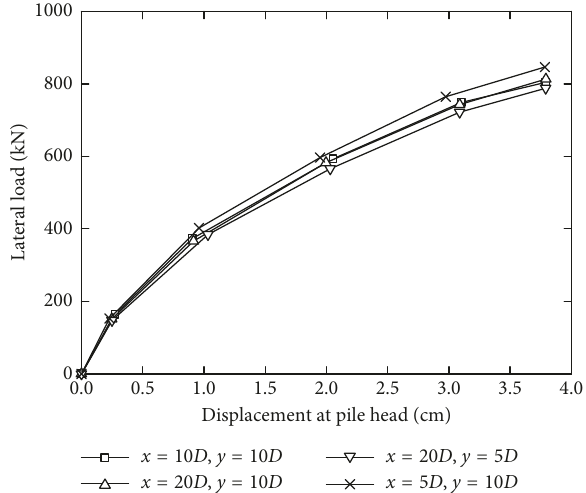
Figure 3: Effect of boundary condition on the load-displacement